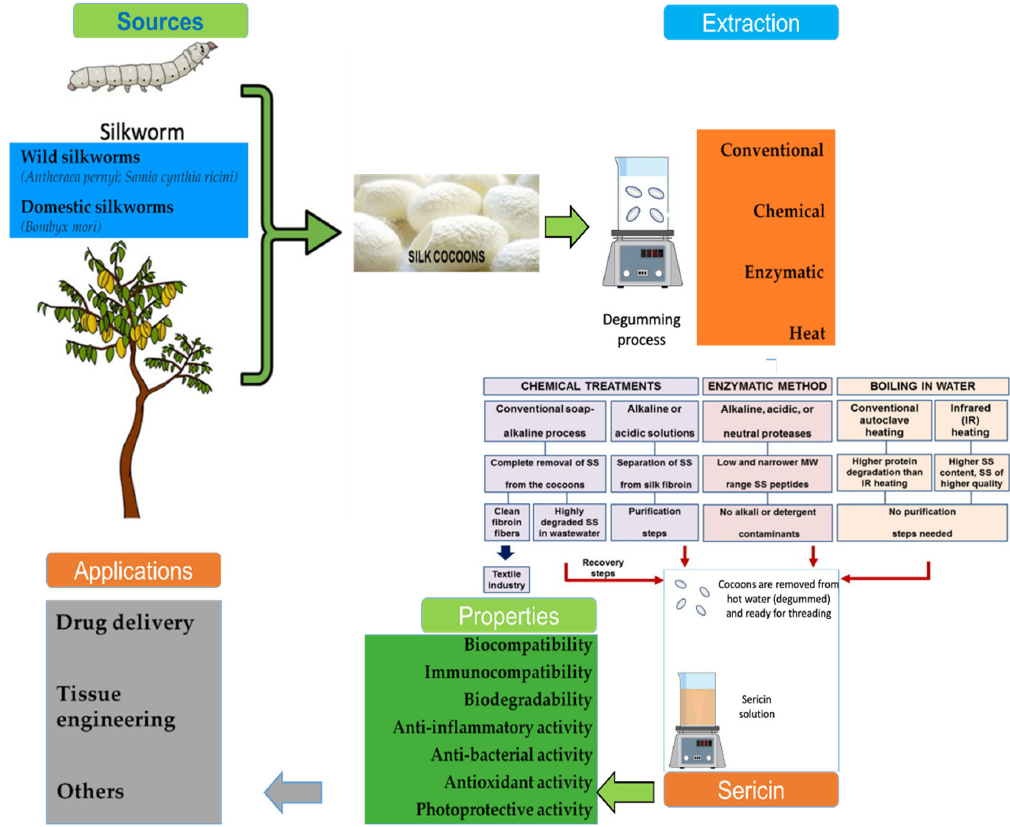
Figure 2. Graphical presentation of the source, extraction process, characteristics, and applications of sericin. Adopted from Silva et al. [10] under the terms and conditions of the Creative Commons Attribution (CC BY) license (https://creativecommons.org/licenses/by/4.0/), 2022, Licensee MDPI, 4.0 International License, 2021, Springer Nature (originally Figure 2); and from Lamboni et al.